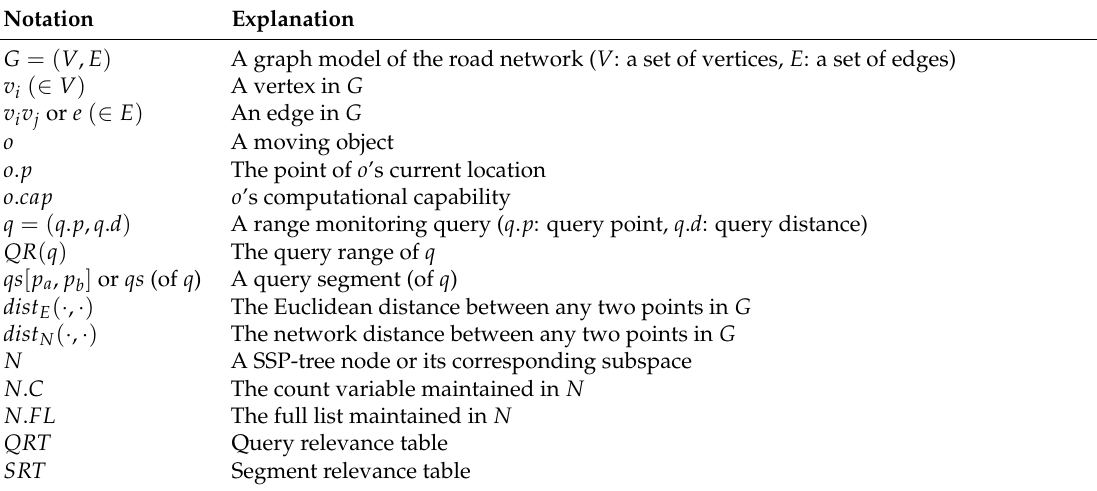
Table 1. Frequently used